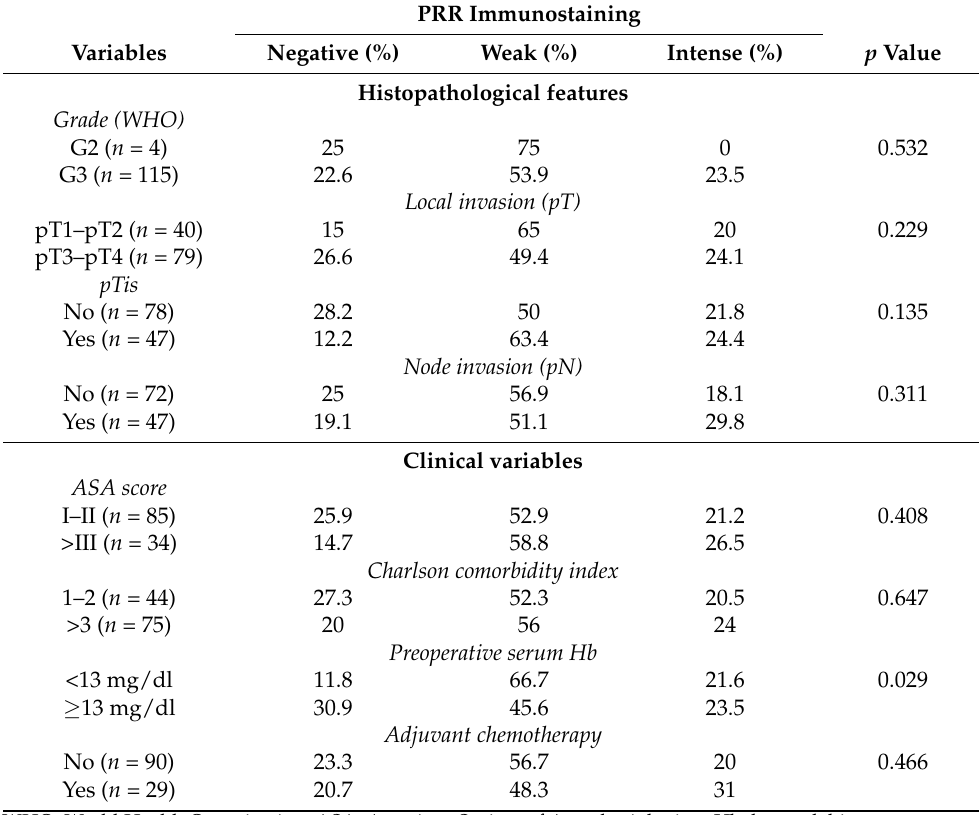
Table 2. Association between PRR expression and clinico-pathological characteristics.